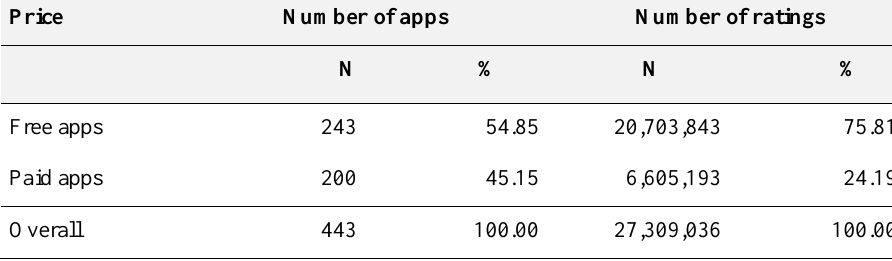
Table 2 – Overview of analysed apps with in-app purchase factor